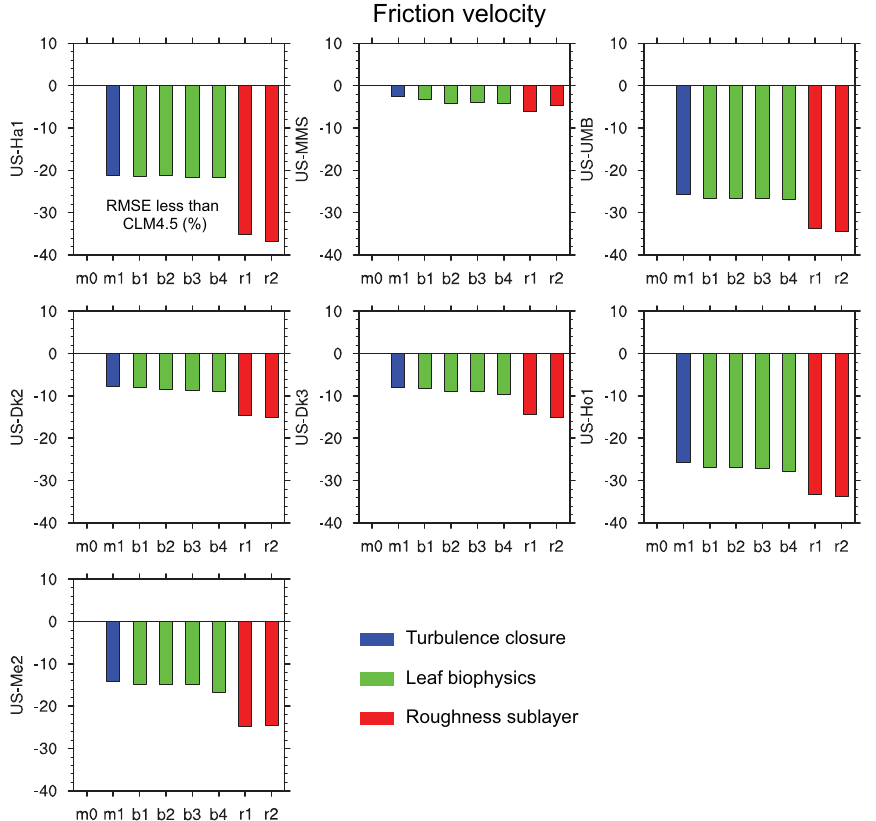
Figure 9. As in Fig. 7, but for friction